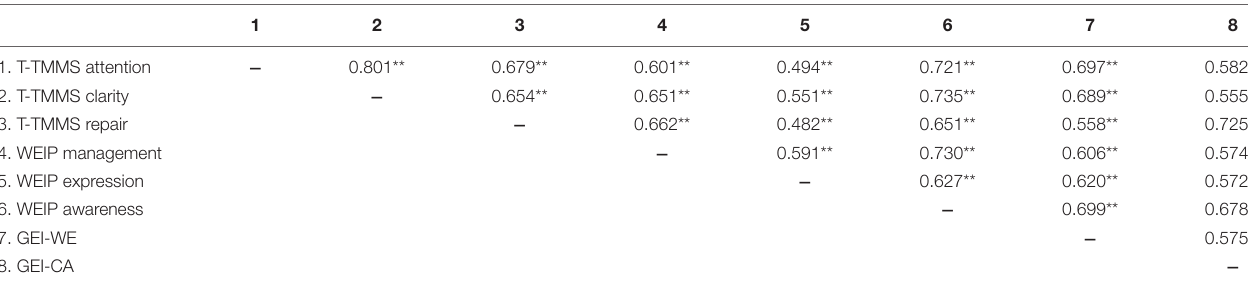
TABLE 3 | Pearson correlation coefficients between T-TMMS scores and scores on the WEIP and GEI